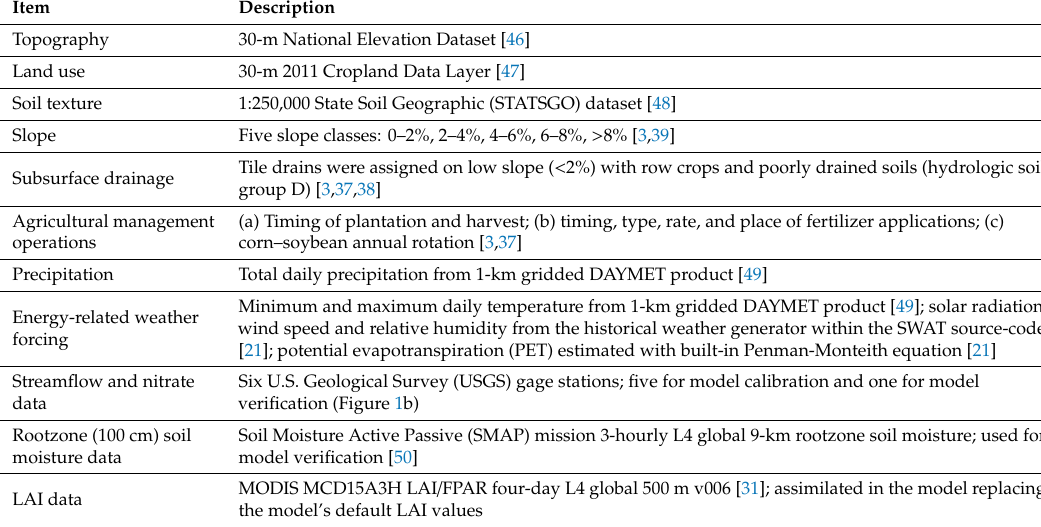
Table 1. Datasets used in the Cedar River Watershed (CRW)